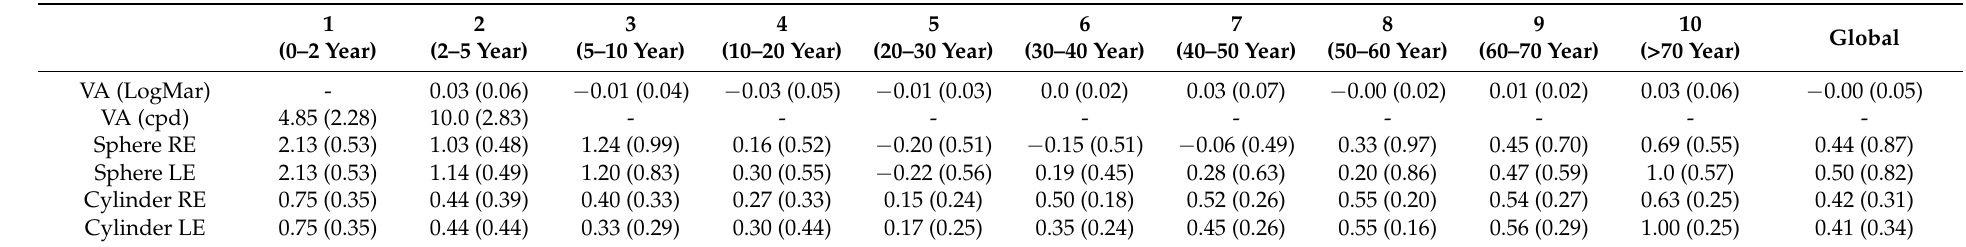
Table 1. Demographic and visual data of the sample population.